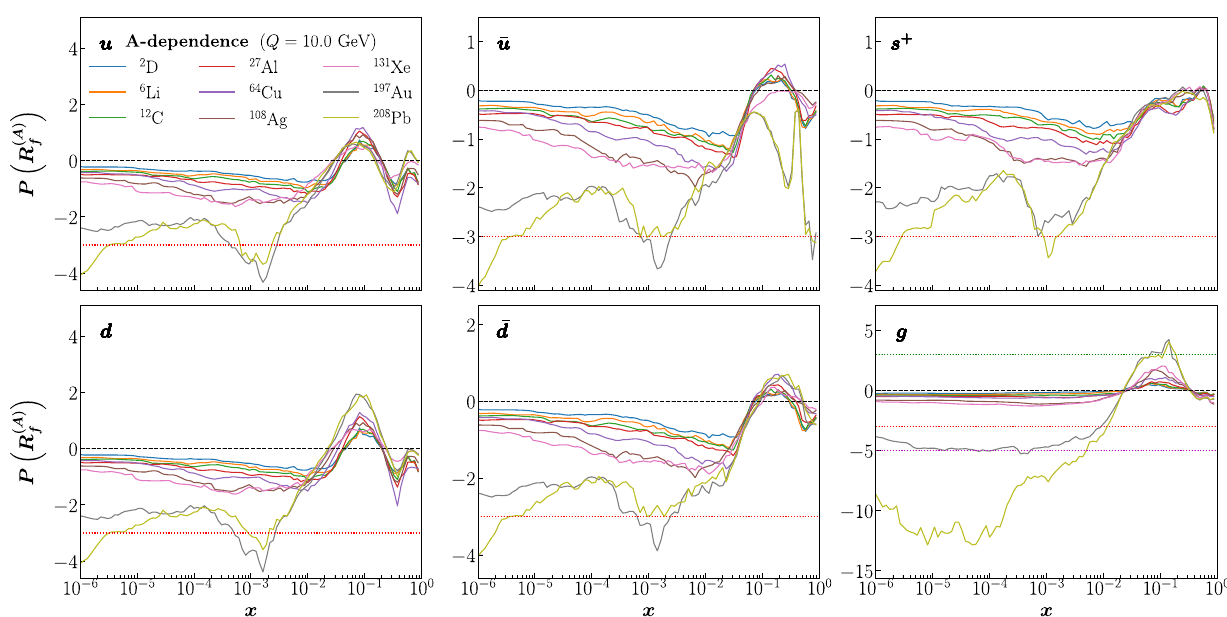
Fig. 13 The dependence with the atomic mass number A of the pulls defined in Eq. (4.2) in nNNPDF3.0 for a range of nuclei from deuterium ( A = 2) up to lead ( A = 208). Recall from Eq. (4.2) that nuclear modifications associated to the different numbers of protons and neutrons